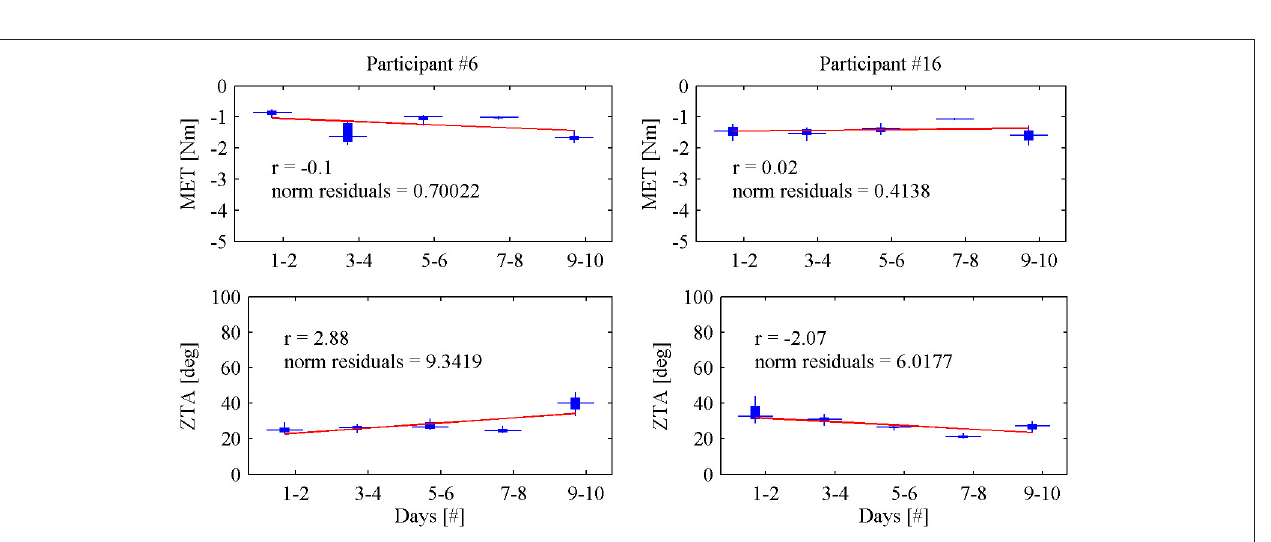
FIGURE 4 | Maximum extension torque ( MET ) and Zero-Torque Angle ( ZAT ) for Participant #6 and Participant #16 over all the treatment